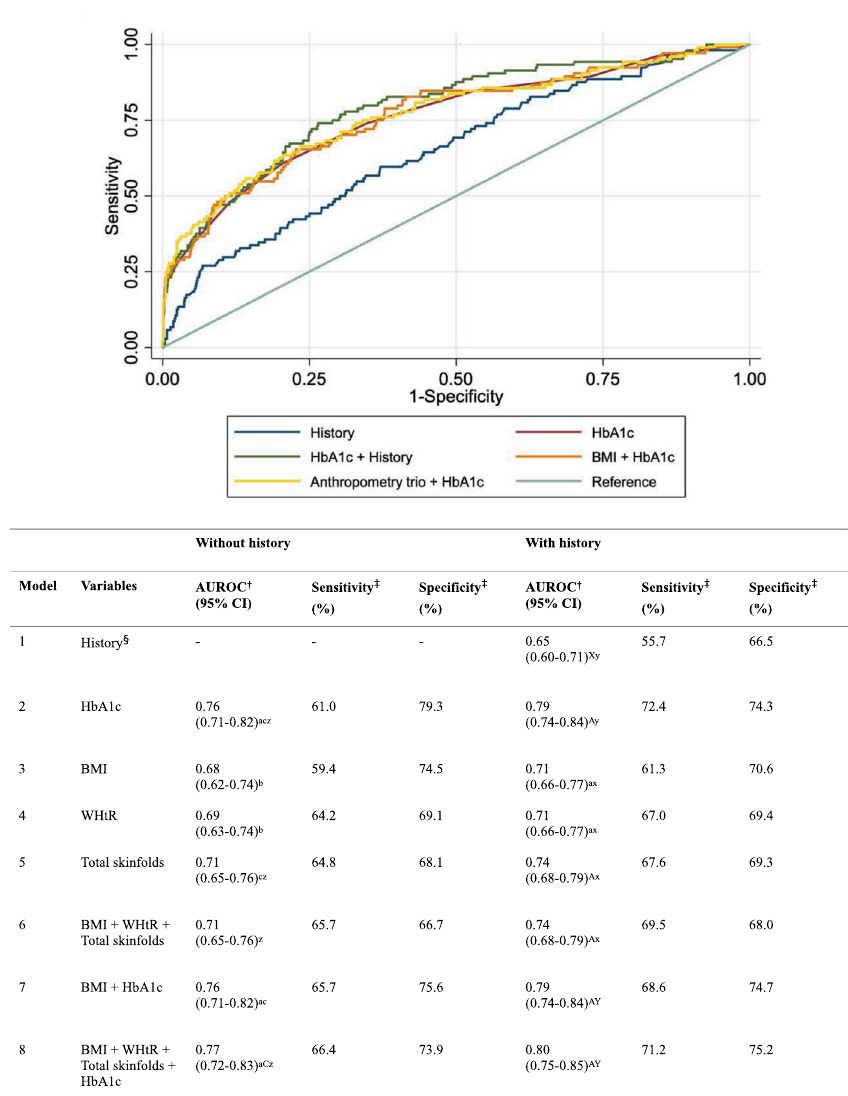
The association of anthropometry, a surrogate marker of insulin resistance, with diabetes in adult populations has been equivocal. Consistent with our results, two meta-analyses found that BMI, WHtR, and WC were equally discriminative in detecting incident diabetes 27 . A Canadian study found skinfold thickness in combination with WC and BMI were strong indicators of glucose intolerance 19 , just as we found a combination of anthropometric measures (BMI, WHtR, total skinfolds) outperformed BMI alone. Other studies utilizing a longitudinal rather than a cross-sectional design, however, reported changes in WC or WHtR over time as a stronger discriminator over BMI. Our finding of no association between ABSI and dysglycemia was in contrast to those of a previous meta-analysis 28 . Given that ABSI was originally developed using data from a US population comprising pre- dominantly Whites, Blacks, and Hispanics, ethnically different body shapes and fat distribution may explain the discrepancy 29 . BMI is the most widely used anthropometric measure as it has negligible costs, is easy to measure and highly reproducible. Conversely, measurements of WC, WHtR, and skinfolds are limited by the lack of technical